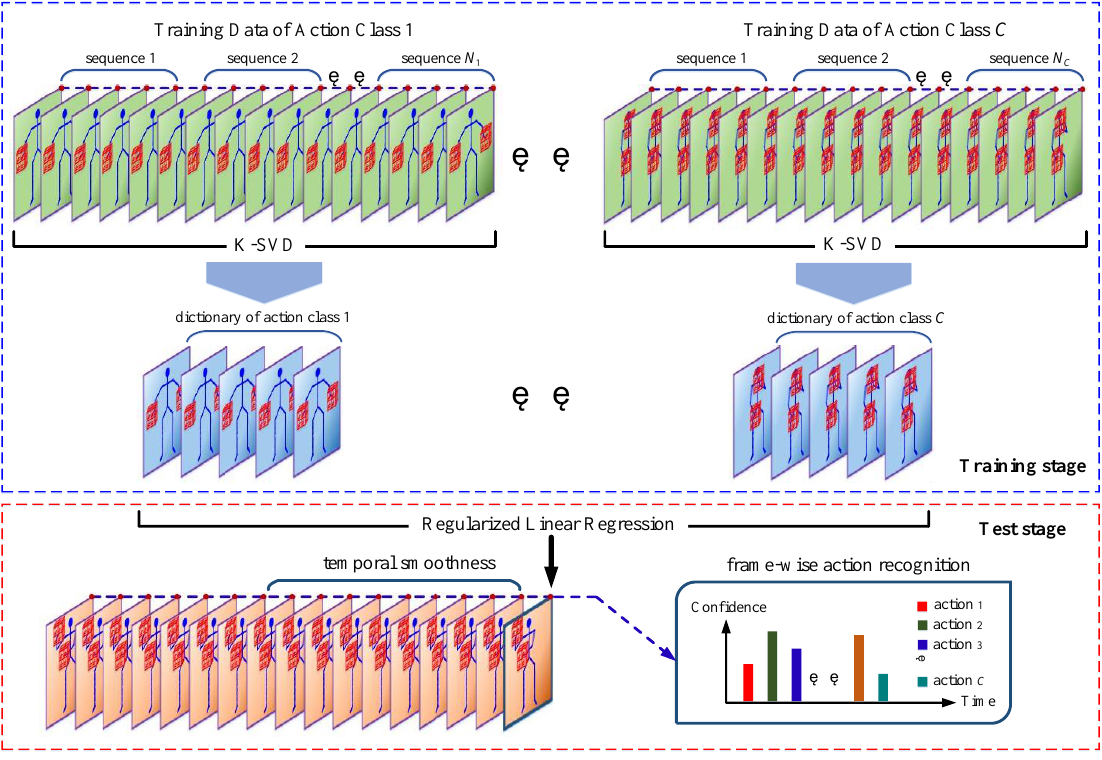
Figure 2. General pipeline of the K-SVD and RLR-based methods. The red wireframes around human hands indicate the LOP feature. N i is the number of training sequences of the i th action. The upper part describes the process of dictionary learning by the K-SVD at the training stage. The lower part describes frame-wise action recognition achieved by the RLR at the test stage. In conjunction with the C learned dictionaries, each test frame is predicted by C confidences associated with the C actions.